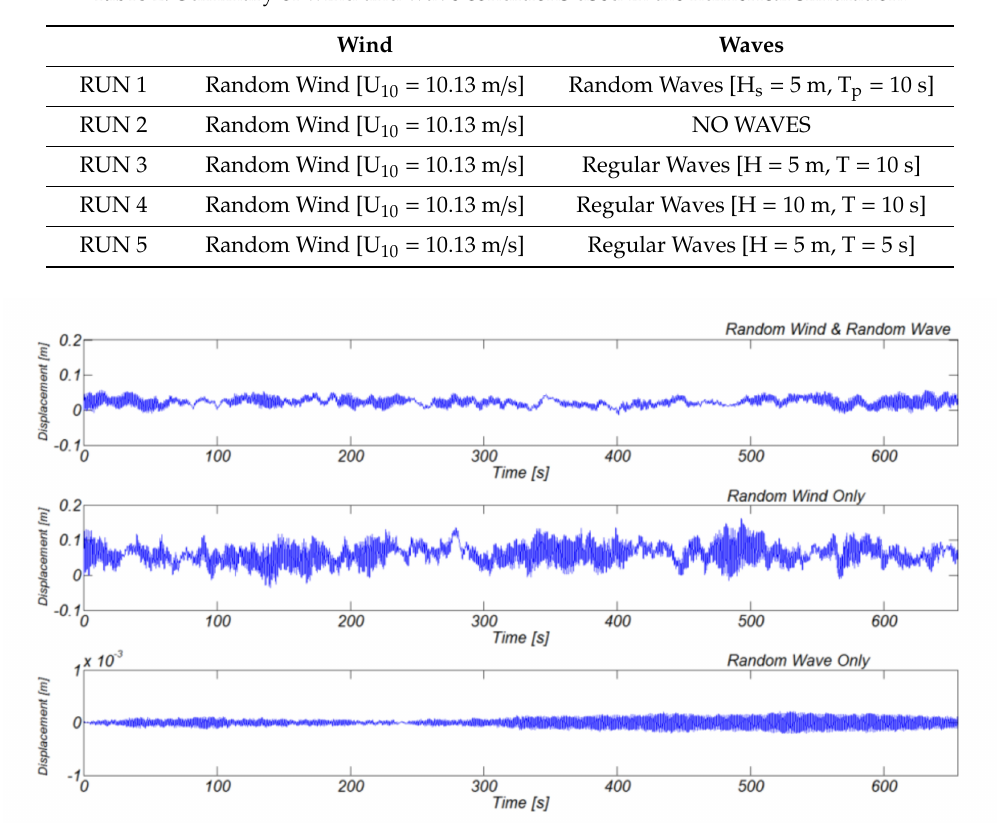
Table 2. Summary of wind and wave conditions used in the numerical simulation.